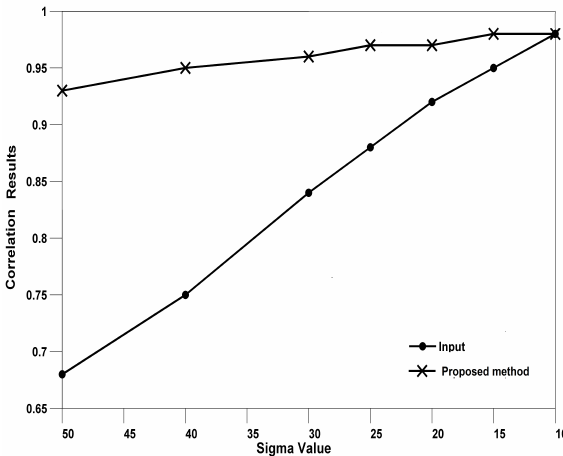
Figure 13. Row 200 of Lena Image, row with Gaussian white noise (Input PSNR = 22.11 dB) and Denoised row with SSplit Method (27.77 dB).